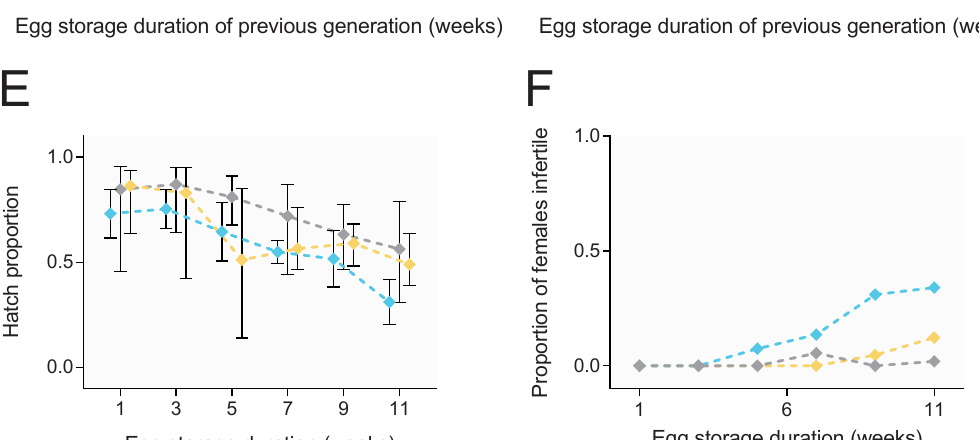
Fig 2. Cross-generational effects of egg storage on Wolbachia -infected and uninfected Ae . aegypti from Australian and Saudi Arabian backgrounds. (A) Egg hatch proportions of eggs stored for 1 to 11 weeks. Females hatching from eggs stored for different periods were then reared to adulthood and measured for their fertility in panels B-D. (B) Proportion of females hatching from stored eggs that were infertile (with no eggs laid) following a blood meal. (C) Number of eggs laid by fertile females hatching from stored eggs in the previous generation. (D) Egg hatch proportions of fertile females hatching from stored eggs in the previous generation. (E-F) Egg hatch proportions of stored eggs (E) and female infertility (F) measured in a repeat experiment which included the w MelM S population. Symbols show medians, while error bars are 95% confidence intervals. Error bars in panels B and F are not shown as data are binomial. Data points within each time point have been offset to avoid